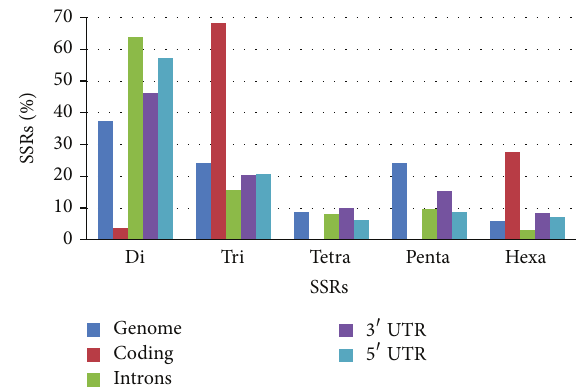
Figure 4: Frequency (%) of the number of each SSR motif identified on different cassava genome